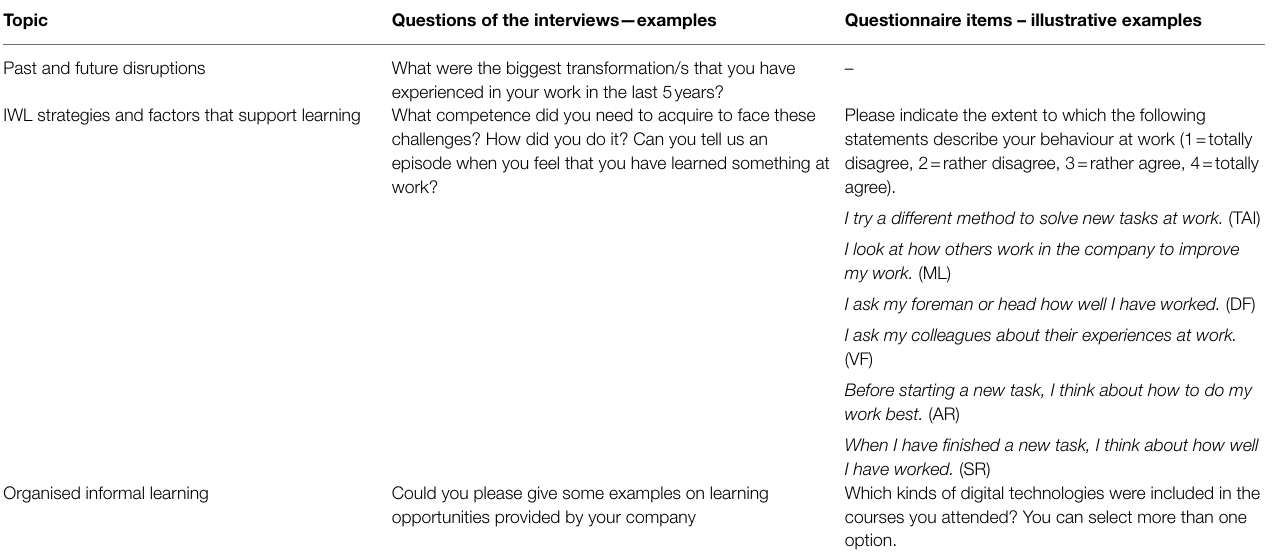
TABLE 2 | Data collected from interviews and questionnaire, respectively, with examples of questions and items. Topic